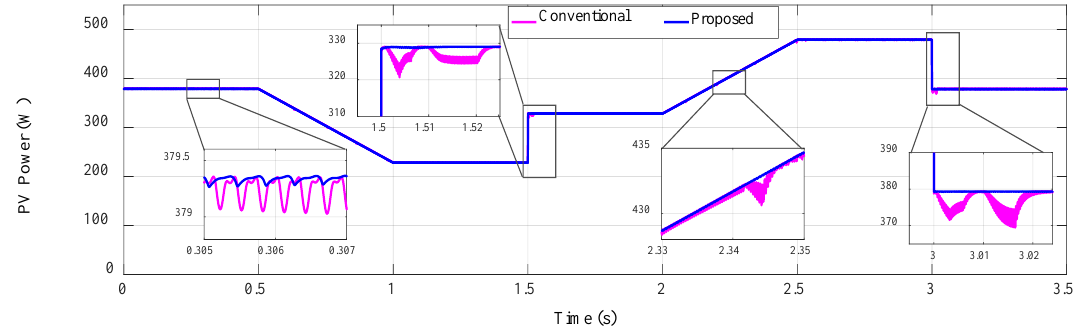
Figure 13. PV voltage with conventional and proposed VO-MPPT methods.